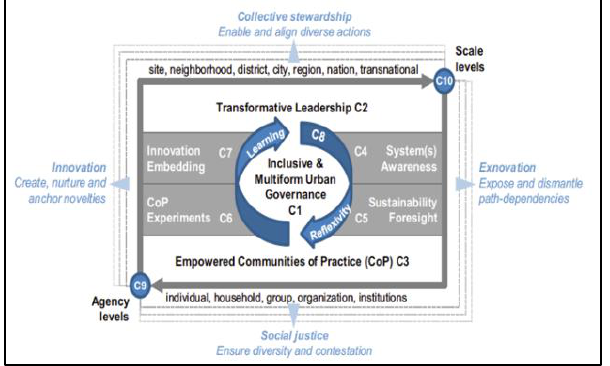
Figure 1. Conceptual framework for urban transformation capacities (Wolfram et al, 2019; Wolfram